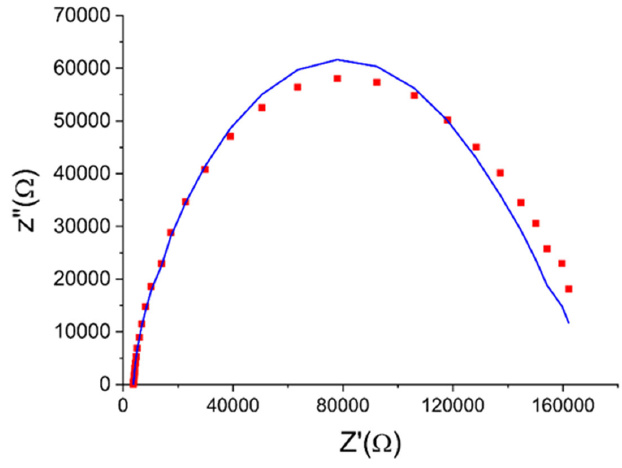
Figure 3. Niquist plot together with fitting parameters calculated. Squares – experimental data, solid line – fitted one.